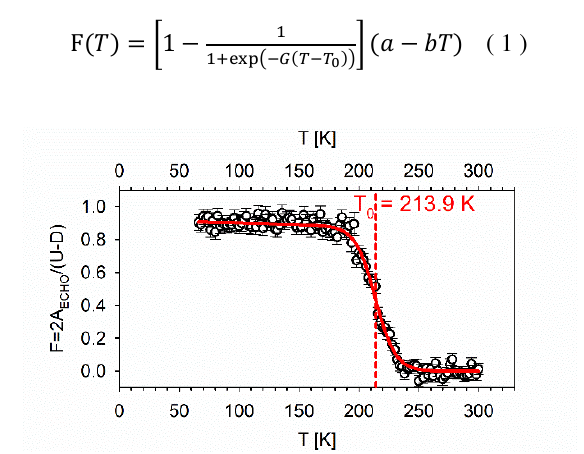
Fig. 2. Illustration of how the inflection temperature point was obtained.